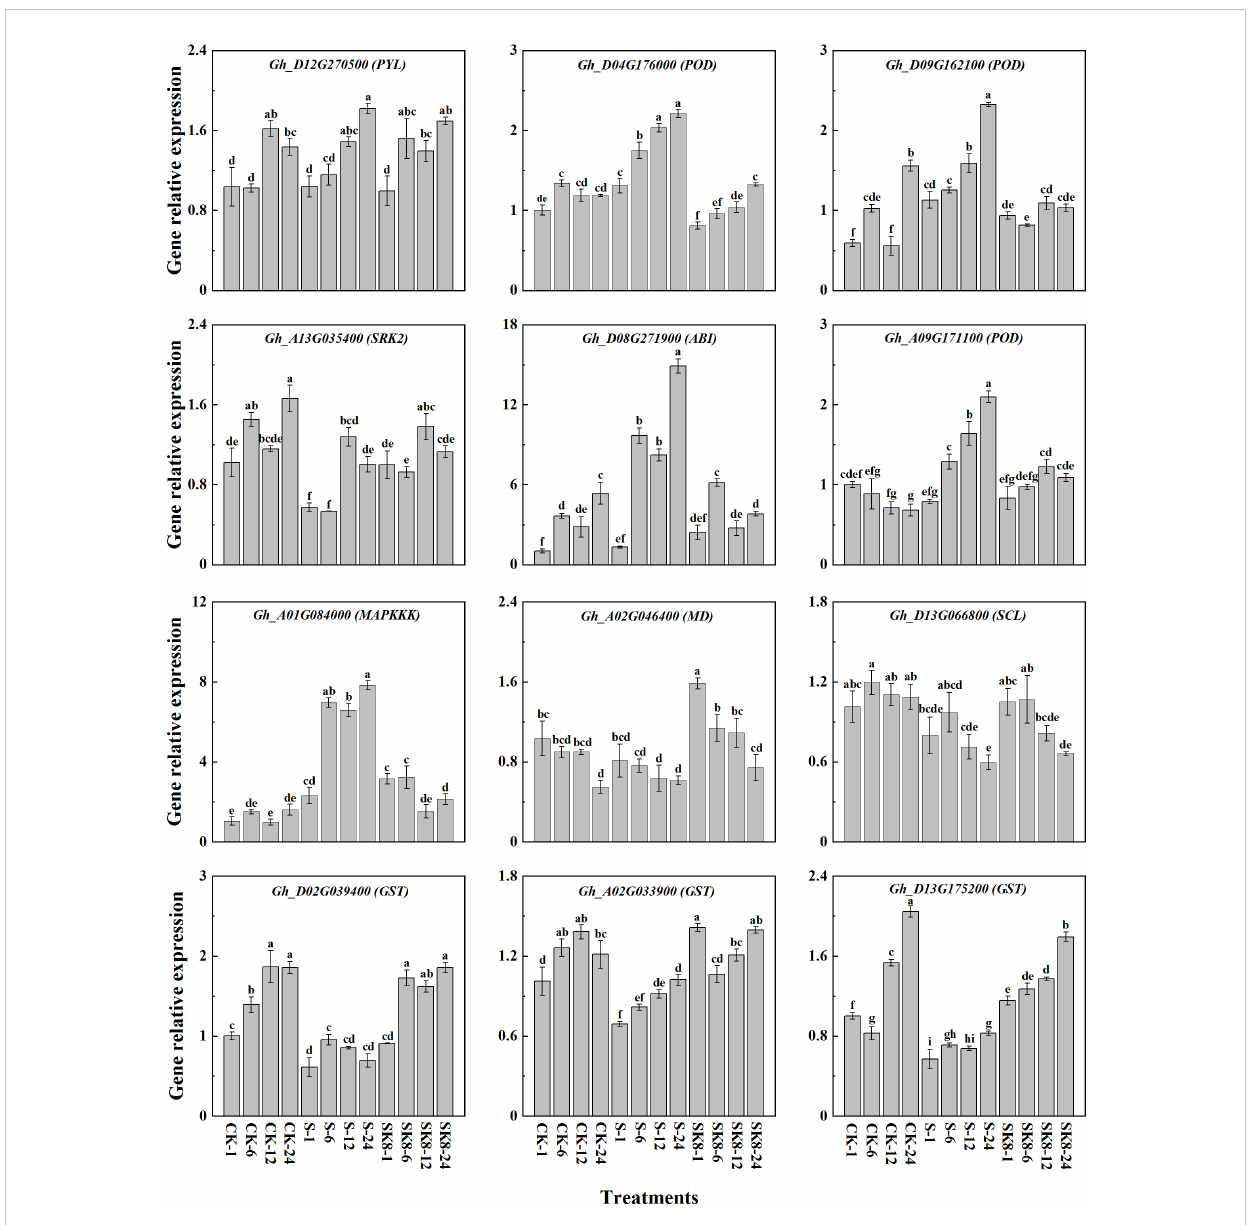
FIGURE 8 Validation of the hub genes by RT-qPCR. Different letters represent signi fi cant differences at the 0.05